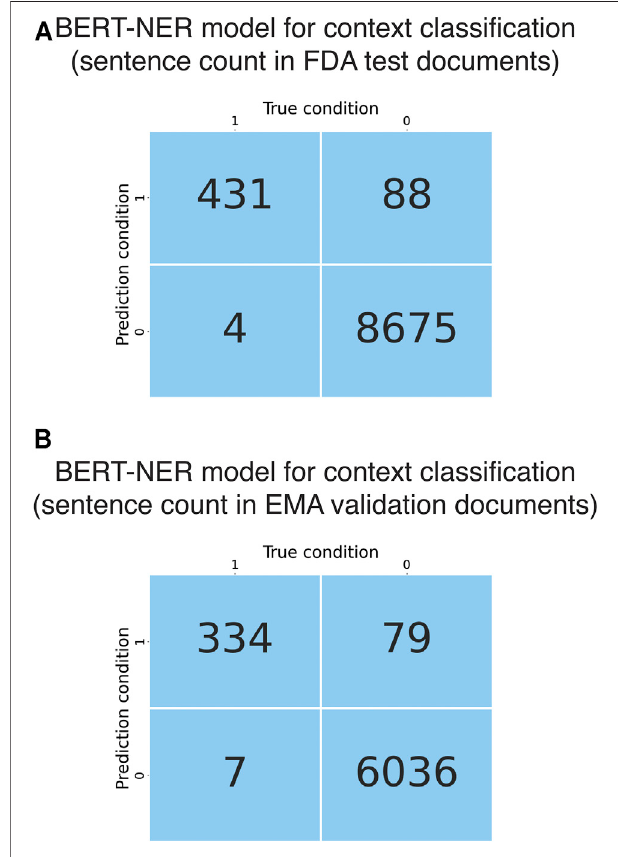
FIGURE 3 | Evaluation and validation of the BERT NER models for context classi fi cation. (A) Confusion matrix obtained from evaluation of the BERT-basedcontextclassi fi cationmoduleusingtheFDAtestdocuments. (B) Confusion matrix obtained from evaluation of the BERT-based context classi fi cation module using the EMA validation